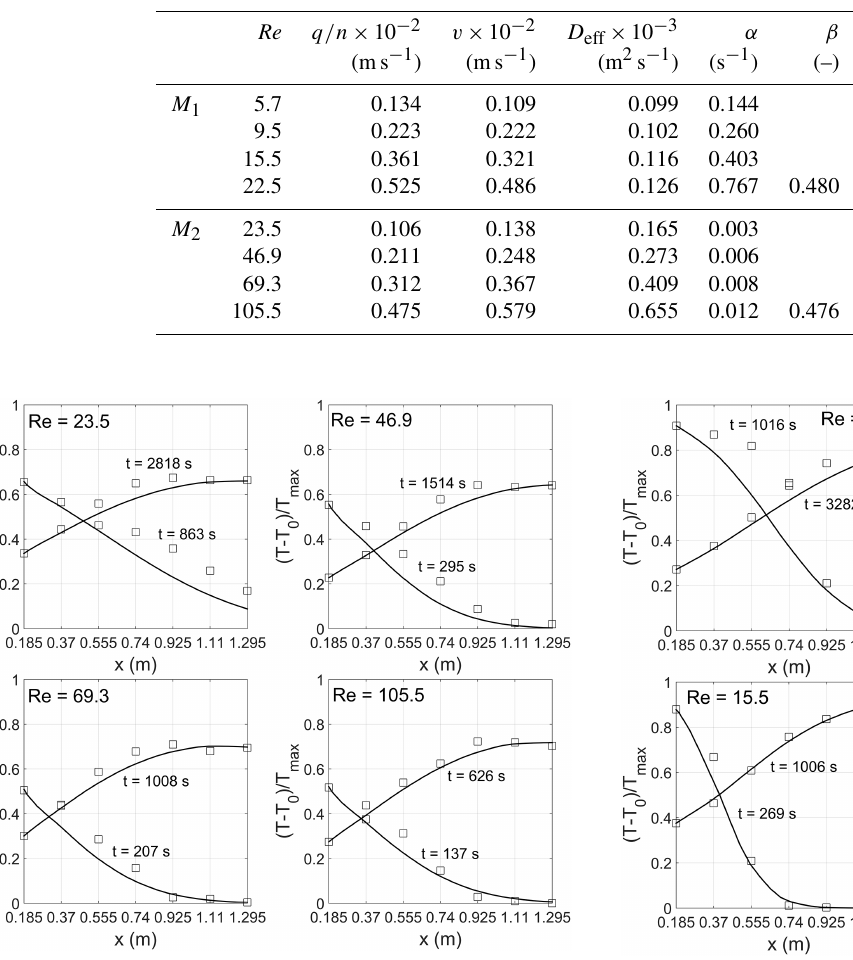
Figure 3. Temperature distribution for increasing Re values along the porous column filled with material M 1 . The two curves repre- sent the inlet and the downstream temperature. Squares represent the experimental values, the continuous lines represent the simu- lated values.